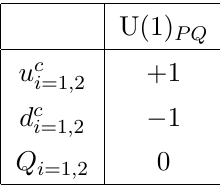
Table 1 . U(1) PQ charge assignments for the (cid:12)rst two generations, where we have taken all (cid:12)elds to be left-handed spinors. The third generation quarks are neutral under U(1) PQ . shift symmetry. This can be achieved by assigning U(1) charges to the SM quarks in PQ a way that does not make U(1) anomalous under QCD. In this work we focus on a PQ scenario where the U(1) charge assignment respects a U(2) (cid:2) U(2) (cid:13)avor symmetry PQ